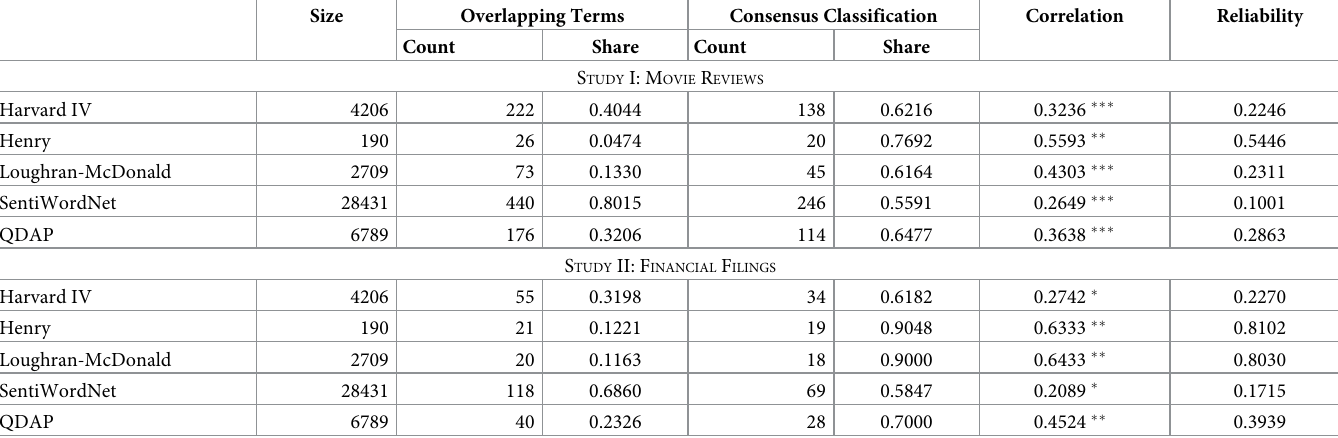
Table 4. Comparison of human classifications to statistical